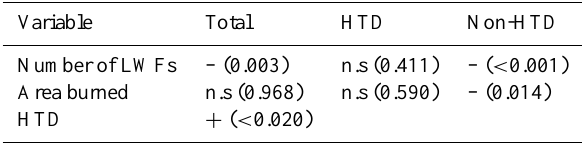
Table 1. Trends in annual number of large wildland fires (LWFs), annual area burned, and annual number of high temperature days (HTDs) in Arag´on from 1978 to